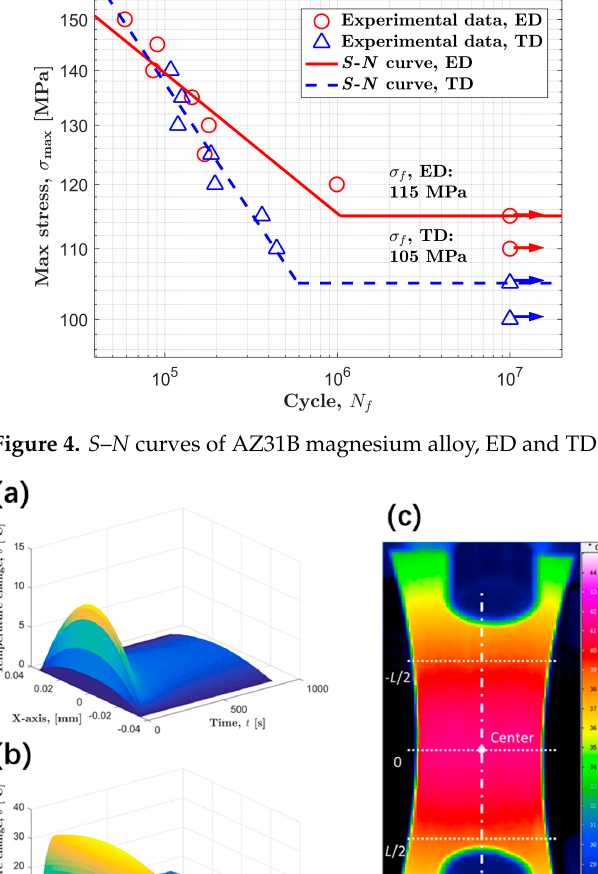
Figure 4. S – N curves of AZ31B magnesium alloy, ED and TD.